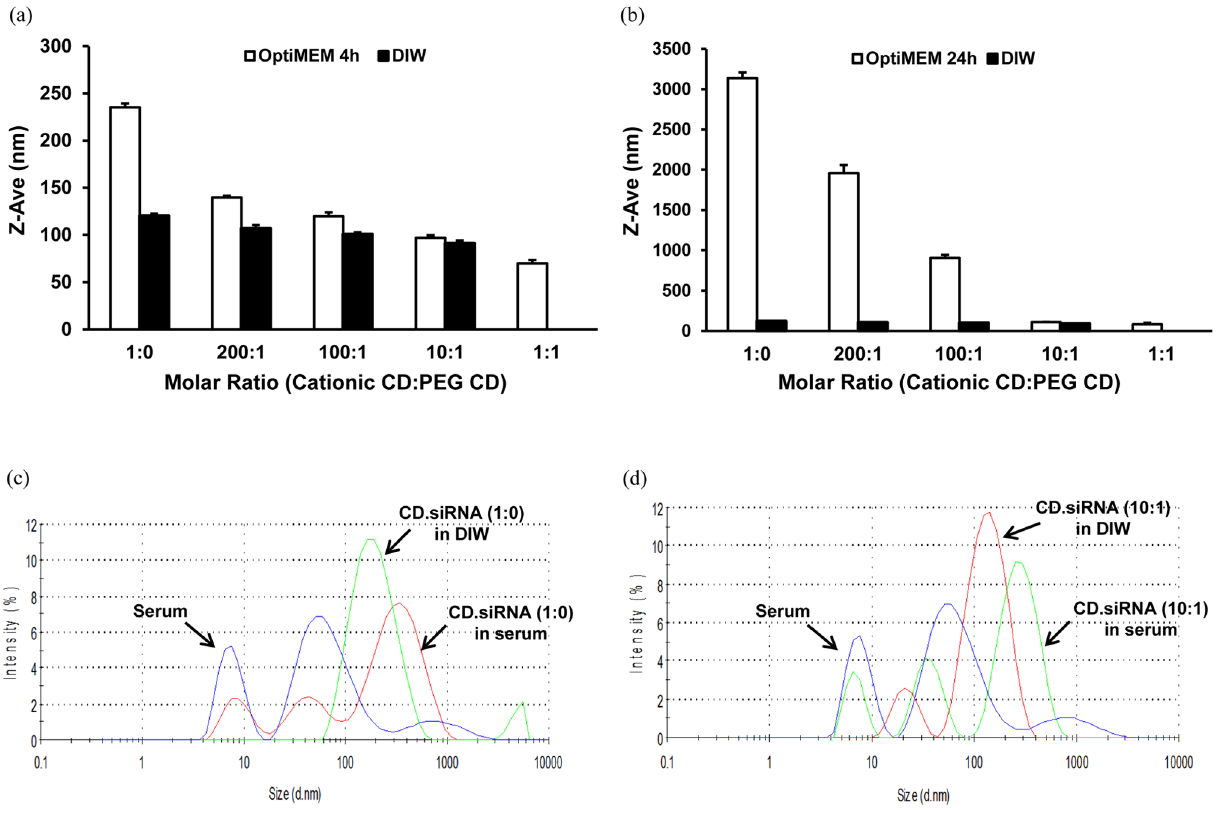
Figure 3. Stability of co-formulated CD.siRNA complexes . Particle size of complexes after incubation in (a, b) OptiMEM H or (c, d) 90% FBS. (a) and (b) depict 4 and 24 hours respectively. (c) and (d) depict co-formulated CD.siRNA complexes at molar ratios 1:0 and 10:1 respectively.